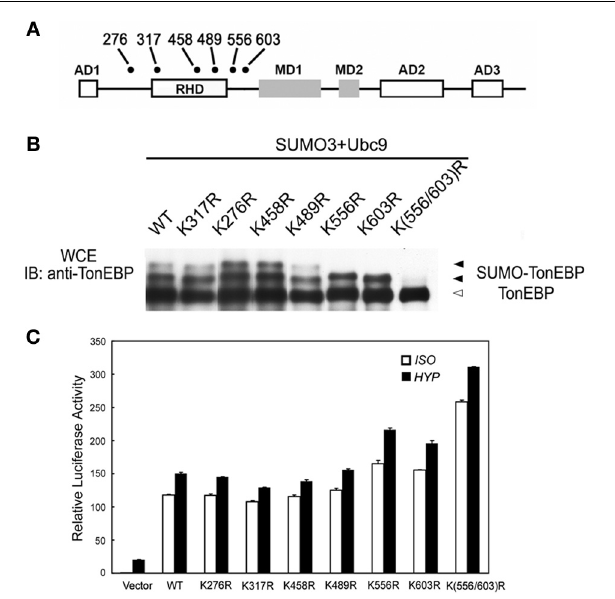
FIGURE 3 | TonEBP is sumoylated on lysines 556 and 603. (A) Positions of lysine residues that fit the consensus sequence for sumoylation ( (cid:2) KxE: (cid:2) is a large hydrophobic residue; x is any residue) on a schematic primary structure of TonEBP. Rel homology domain (RHD), three activation domains (AD), and two modulation domains (MD) are shown. (B) HEK293 cells were transfected with wild type TonEBP (WT) or each of the TonEBP mutants shown along with SUMO3 and Ubc9. The cells were cultured for 4h in hypertonic medium before immunoblot detection of TonEBP. Positions of TonEBP and sumoylated TonEBP (SUMO-TonEBP) are indicated. (C) HEK293 cells were co-transfected with a TonE-driven luciferase reporter plus empty expression plasmid (Vector) or expression plasmid containing WT or each of the TonEBP mutants as indicated. The cells were cultured for 4h in isotonic (ISO) or hypertonic (HYP) medium before analysis of luciferase. Expression of luciferase activity is shown relative to isotonic vector control. K556R or K603R is significantly different from WT or K(556/603) both in ISO and HYP: p < 0 . 01. Mean + s.e.m., n =